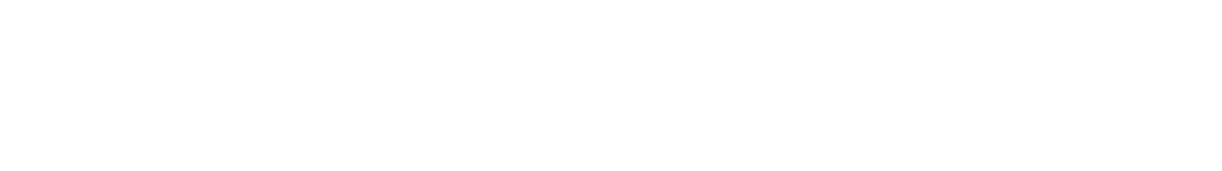
Frontiers in Virtual Reality |